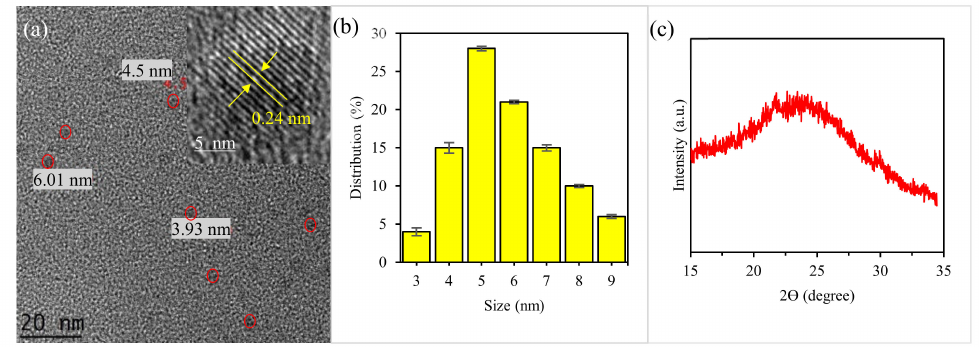
Figure 2. ( a ) TEM of CDs, ( b ) particle size distribution, ( c ) XRD patterns of CDs. Inset: HRTEM of